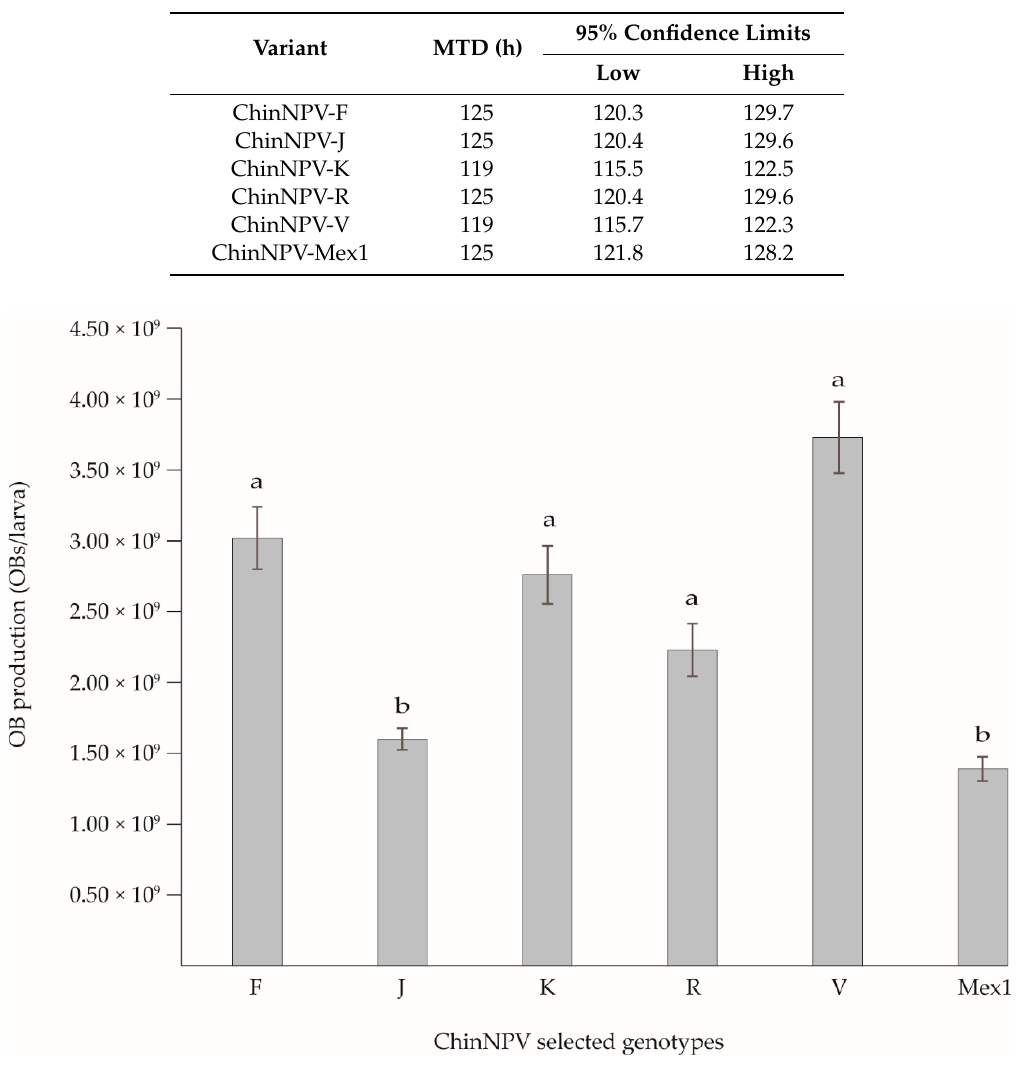
Figure 4. Mean OB production values of ChinNPV-Mex1 and selected genotypic variants in C. includens fifth instars. Error bars indicate the standard error. Columns headed by identical letters did not differ significantly (Kruskal-Wallis, p > 0.05).